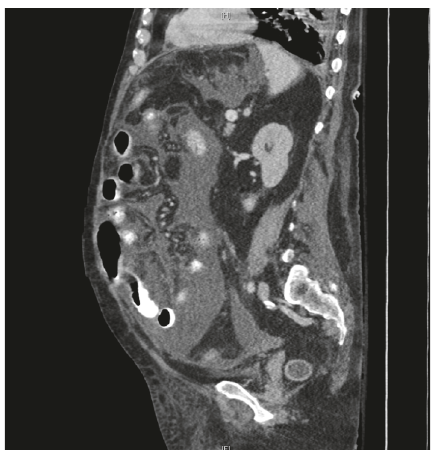
Figure 5: Resolution of the mesenteric and the peritoneal thicken- ing after initiation of